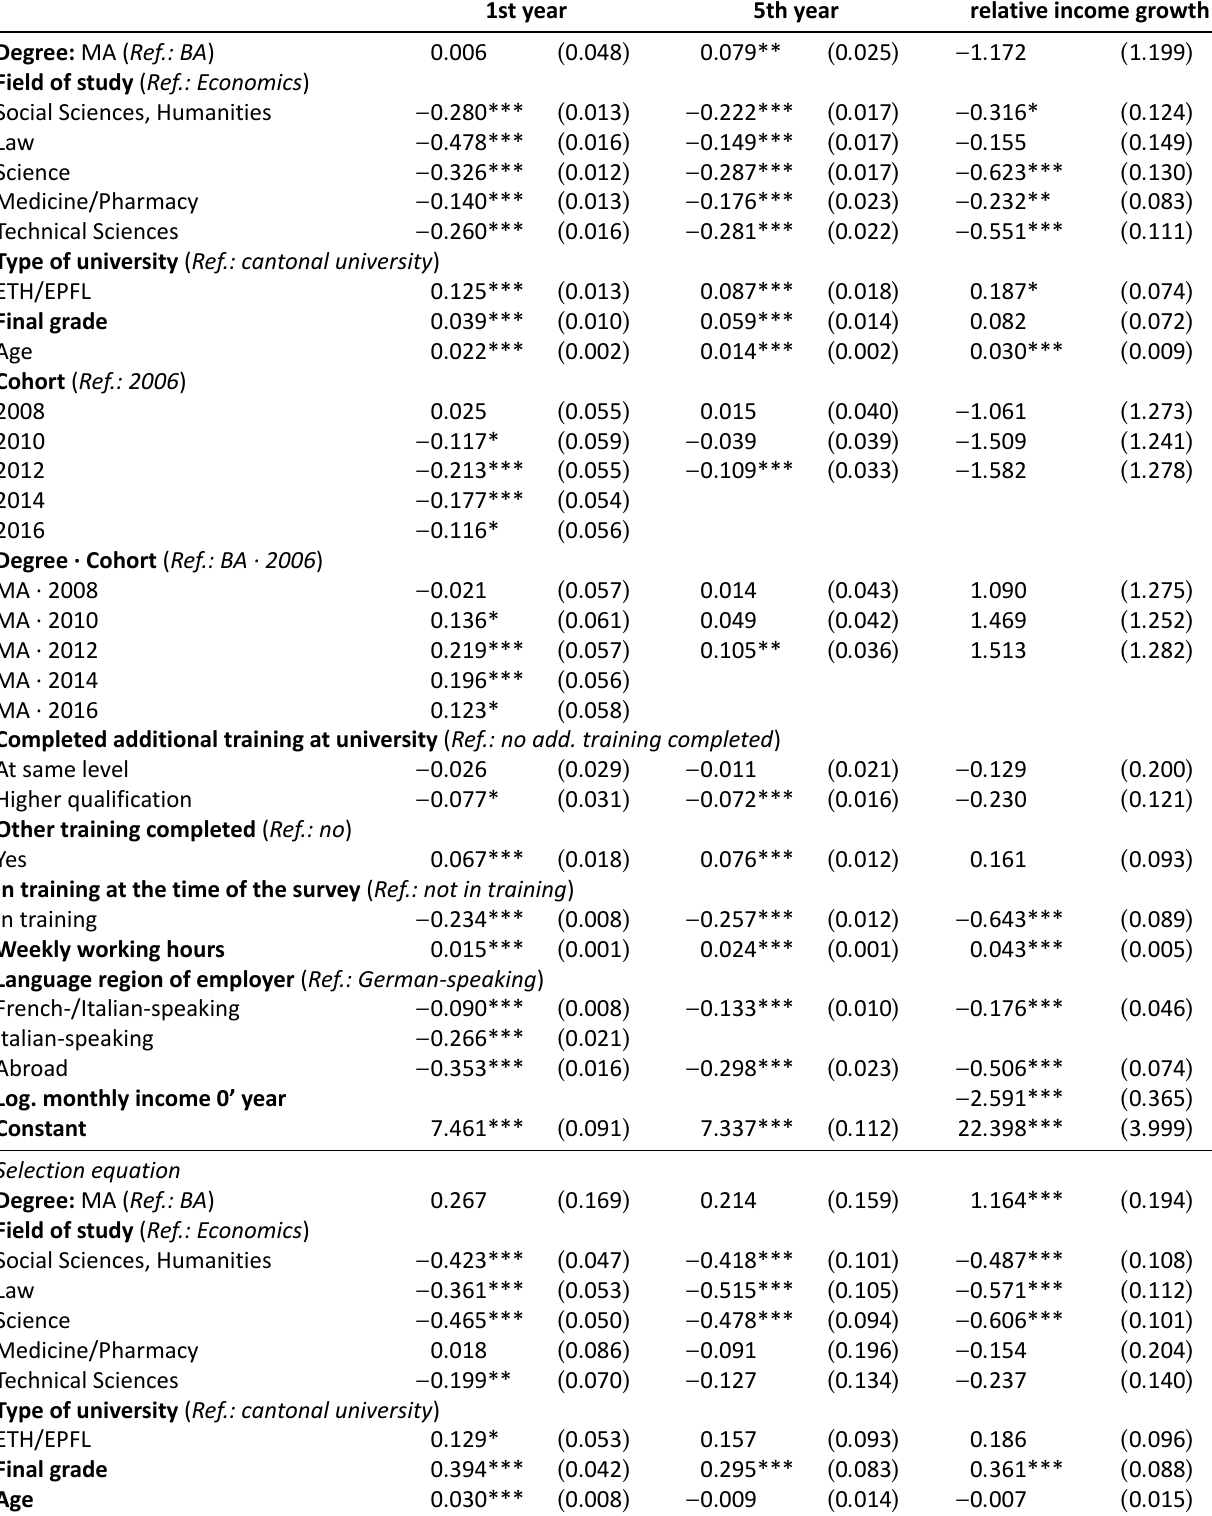
Table A5. Men’s monthly income (log.) in the first and fifth year after graduation and their relative income growth; models with interaction terms—shown in Figure